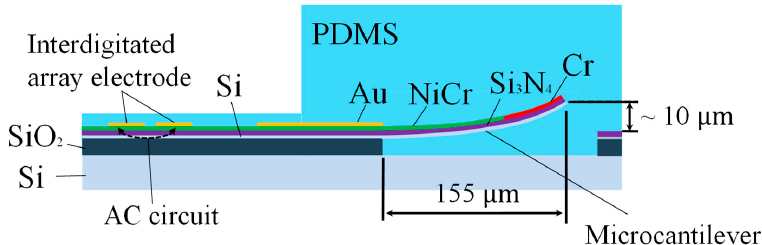
Figure 1. A schematic diagram of cross-sectional view of the sensor.